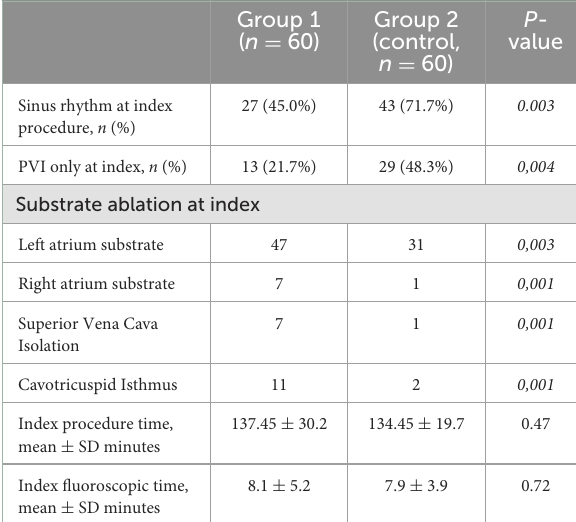
TABLE 2 Procedural characteristics ( n = 120).